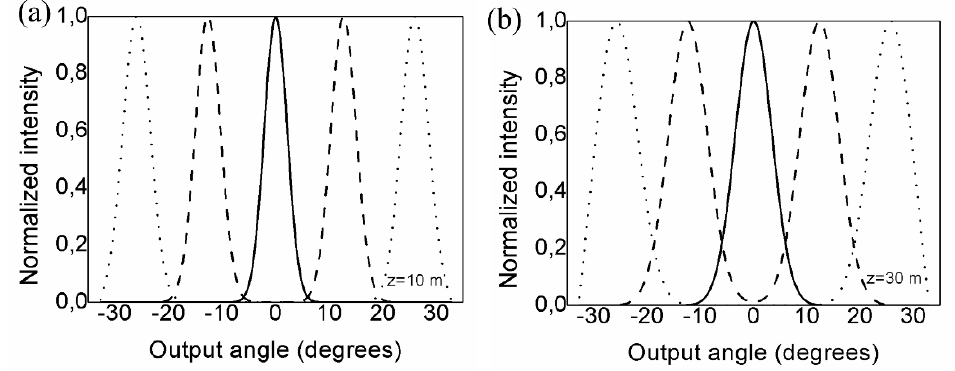
Figure 3. Normalized output intensity at different lengths of the multimode SI air-clad silica optical fiber obtained as solutions of Equation (2) for D = 3.5 × 10 − 5 rad 2 /m, three launch beams in the Gaussian form, and input angles θ 0 = 0 ◦ (solid line), 13 ◦ (dashed line) and 26 ◦ (dotted line), with (FWHM) z=0 = 3.9 ◦ for: ( a ) z = 10 m and ( b ) z = 30 m.